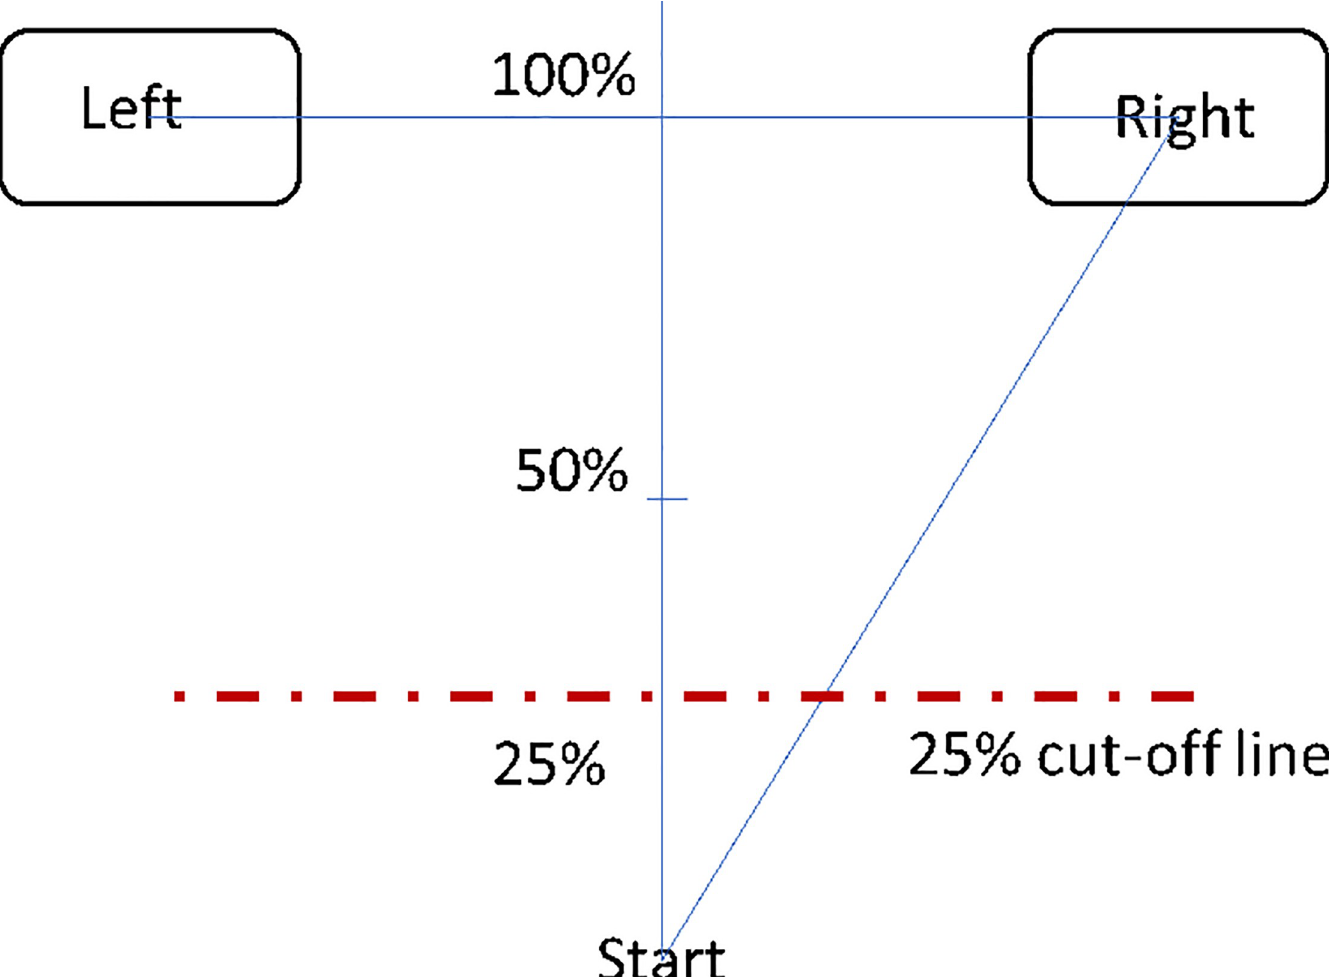
Fig 5. Response inhibition criteria. Red dashed line drawn at 25% of the vertical distance connecting the start position and an end button depicts the cutoff for the response in a “stop” trial.